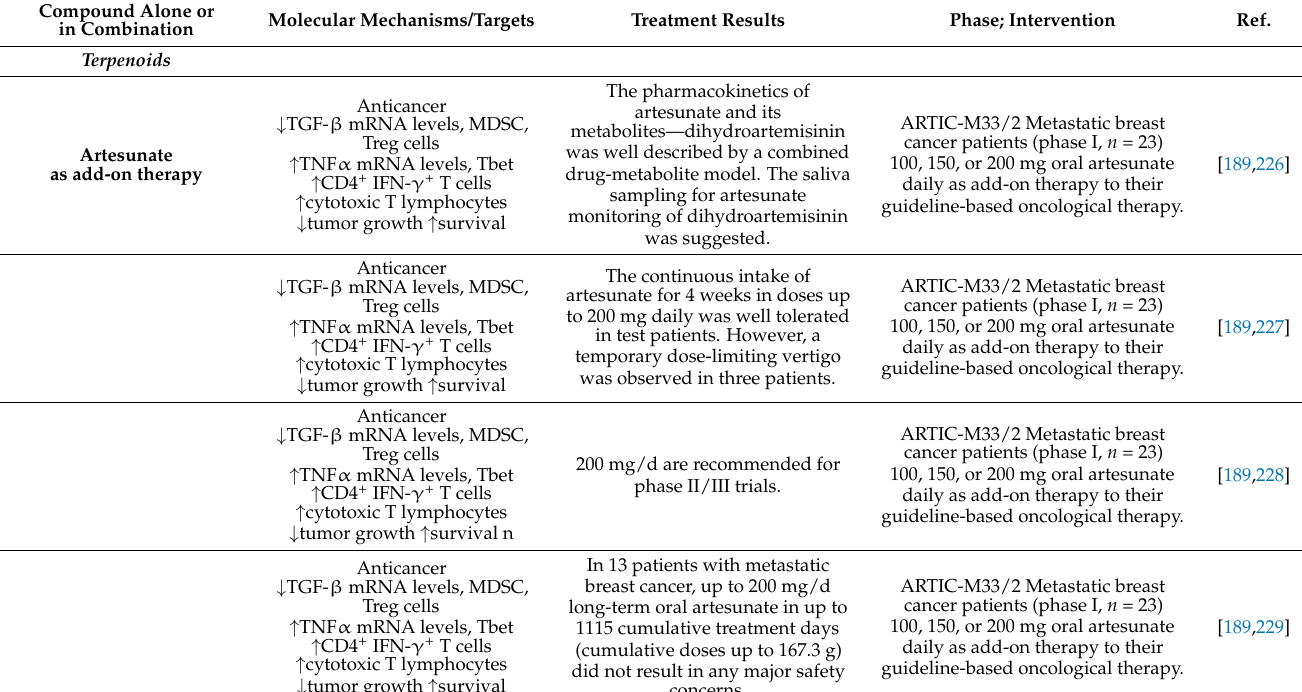
Table 2. Clinical studies concerning the anticancer effects of monotherapy of plant-derived drugs or in combination with other clinical